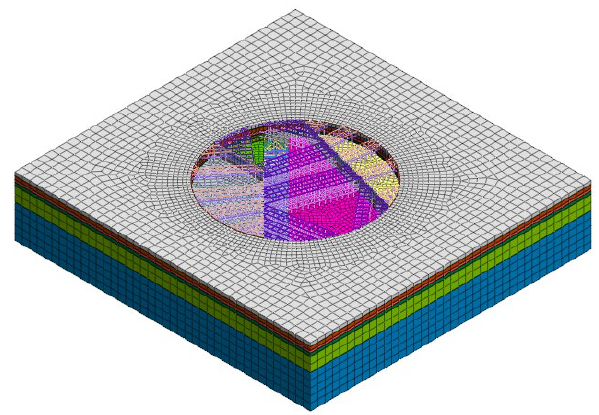
Figure 7. Three-dimensional finite element model of the LDCFP.